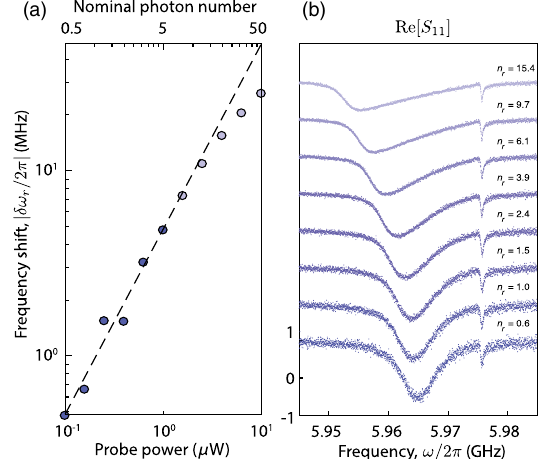
≡ FIG. 4. Nonlinear spectroscopy. (a) Frequency shift δω r ω − ω 0 Þ of the microwave resonance as a function of n r ð r Þ r ð the probe tone power (at output from VNA). Since the anharmo- nicity χ is negative, the resonator redshifts as its occupation n r increases; here, we plot the absolute value of the shift for clarity. As expected from a linearized model of a resonator with a Kerr nonlinearity, the shift has a linear dependence for weak driving strengths (dark blue points), but it deviates from this trend at stronger driving (light blue points). We can calibrate the on- resonance occupation n by fitting δω to a line in the weak driving r r regime (dashed black line), using a value of χ = 2 π ¼ − 2 . 0 MHz for the anharmonicity. (b) Reflection spectra at various values of n , r with the resonator placed to the red side of the mechanical mode. As the occupation increases, the resonator redshifts as expected, while the mechanical mode remains